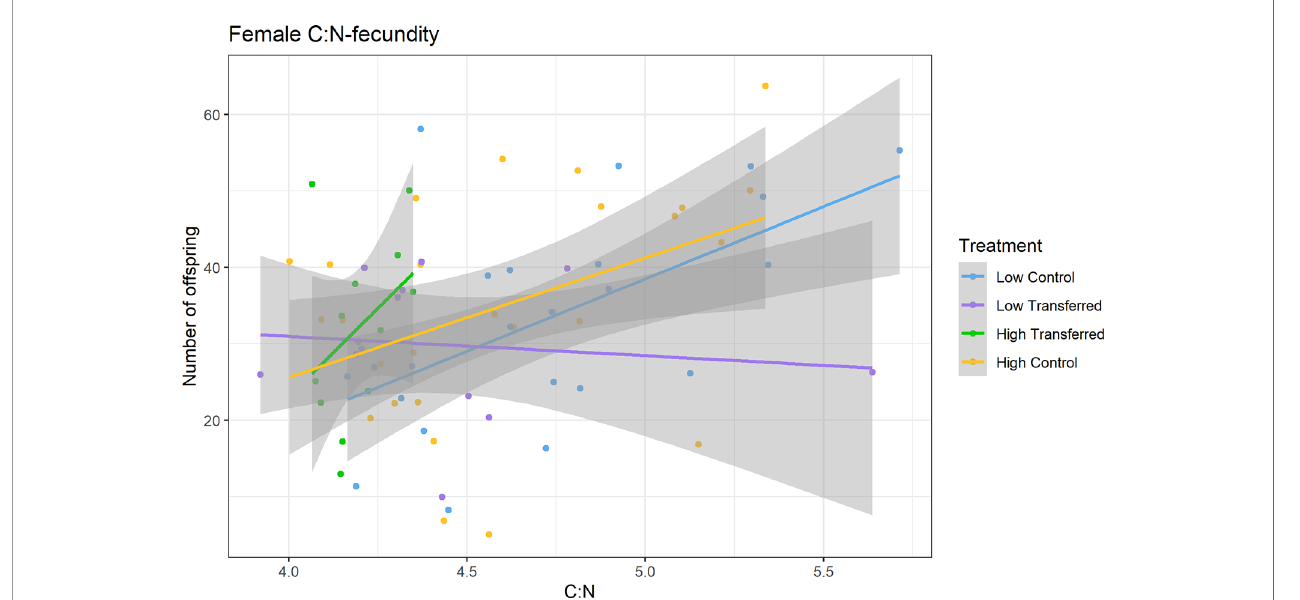
FIGURE 4 | Linear models of female C:N ratios and fecundity (number of offspring per female) by treatment. See Figure 2 for experimental treatment